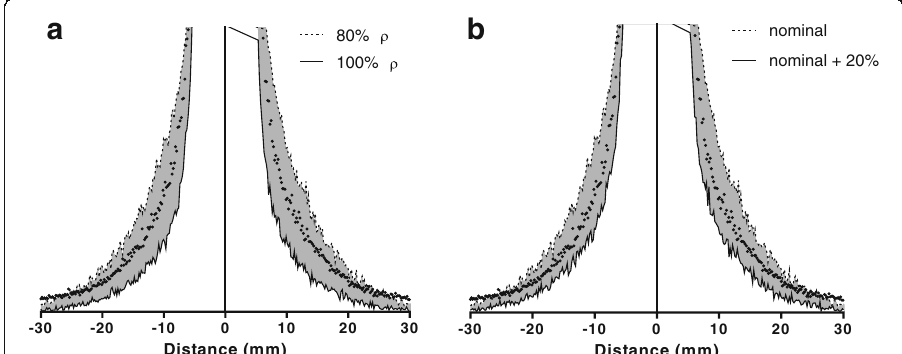
Fig. 12 Monte Carlo simulated line profiles compared to measured, for different material densities ( a ) and septa thicknesses ( b )